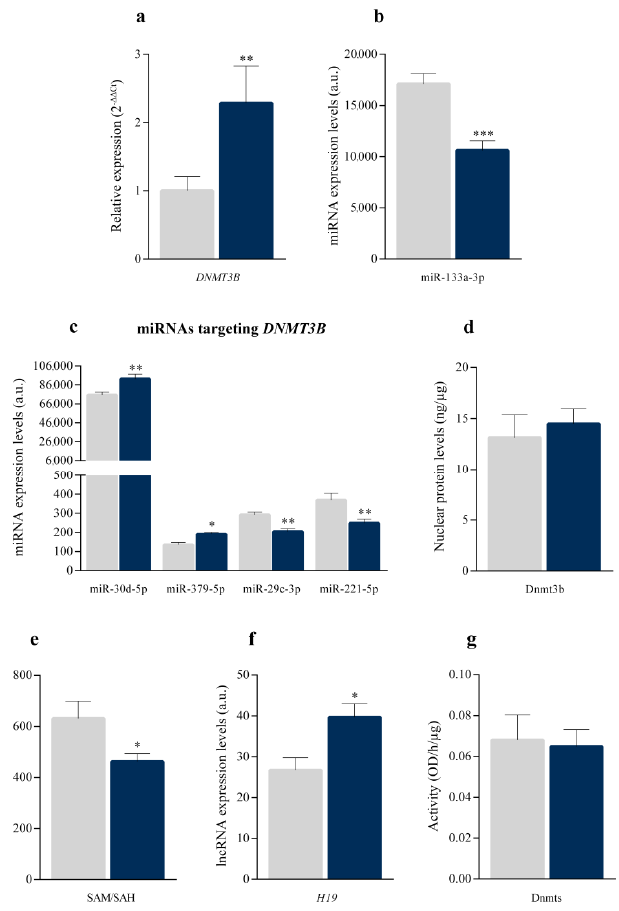
Figure 2. DNMT3B system dysregulation. ( a ) DNMT3B mRNA levels in ischaemic hearts ( n = 14) and controls ( n = 8), using RT-qPCR. ( b ) miR-133a-3p expression levels in ischaemic hearts ( n = 22) and controls ( n = 8), using HiSeq 2500 platform. ( c ) miRNAs expression levels in ischaemic hearts ( n = 22) and controls ( n = 8), using HiSeq 2500 platform. ( d ) Dnmt3b nuclear protein levels in ischaemic hearts ( n = 8) and controls ( n = 8), using ELISA. ( e ) SAM/SAH ratio in ischaemic hearts ( n = 30) and controls ( n = 6), using ELISA. ( f ) lncRNA H19 expression level in ischaemic hearts ( n = 22) and controls ( n = 8), using the Illumina HiSeq 2500 platform. ( g ) Dnmts nuclear activity in ischaemic hearts ( n = 8) and controls ( n = 8), using ELISA. Data are presented as the mean ± SEM. a.u., arbitrary units. Ischaemic cardiomyopathy patients (blue), controls subjects (grey). * p < 0.05, ** p < 0.01, *** p <